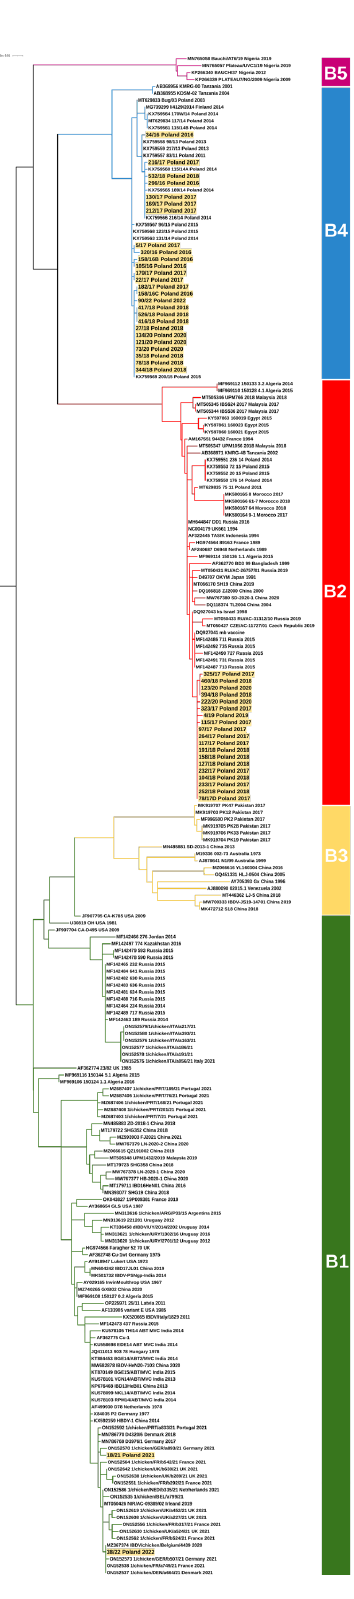
Figure 1. Maximum likelihood phylogenetic analysis of the truncated sequence of ( A ) VP2/ (561nt) and ( B ) VP1 (427nt) genes according to Wang et al. rules [11]. Trees were constructed using GTR + F + I + G4 and TIM2e + G4 with 1000 bootstrap iterations for VP2 and VP1, respec- tively. The main IBDV genogroups are denoted with designation and colors, and the taxa name of the Polish strains characterized in the presented study are highlighted with